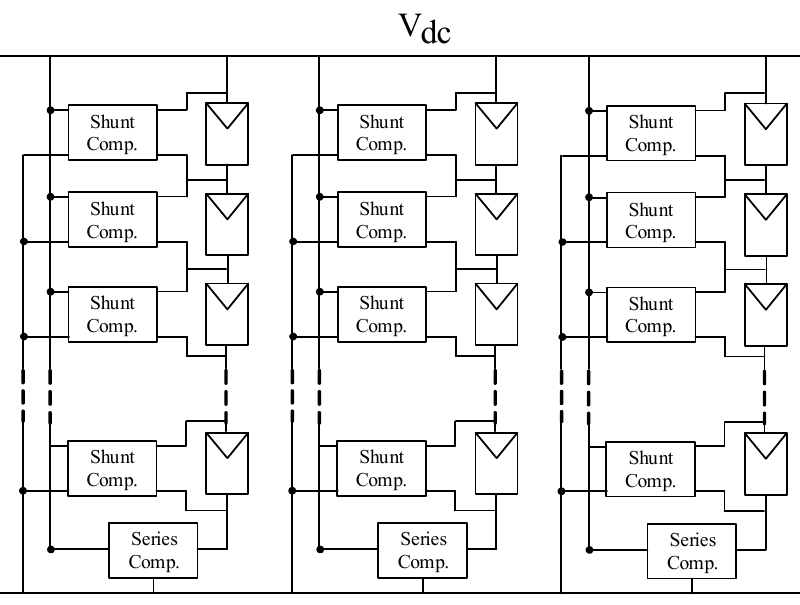
Figure 25. Series-shunt equalizer scheme [54].